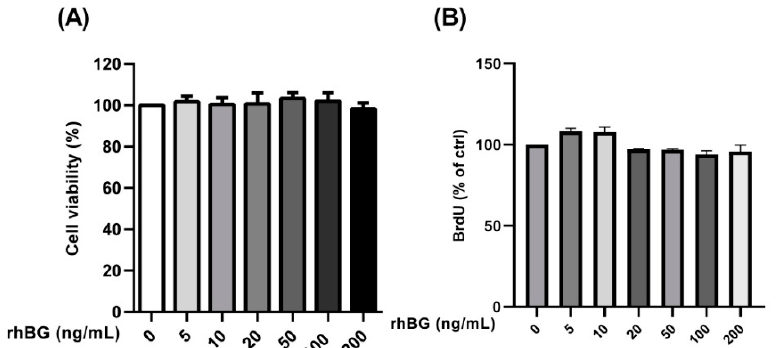
Figure 7. Concentration-dependent effects of recombinant BG (rhBG) on cell viability and proliferation. Endometriotic epithelial 12Z cells were treated with increasing concentrations of the recombinant BG (5–200 ng/mL) and were analyzed for cell viability ( A ) and proliferation ( B ) after 24 h using the CCK-8 and BrdU assay kits, respectively. BG treatment had no effect on the number of viable cells and cell proliferation at the concentrations tested. Untreated cells were used as a control and the mean OD of the control was set to 100%. Each bar represents the mean ± SEM of 3 independent experiments performed in duplicate. Dunnett’s test was used for statistical analysis; rhBG, recombinant betaglycan.